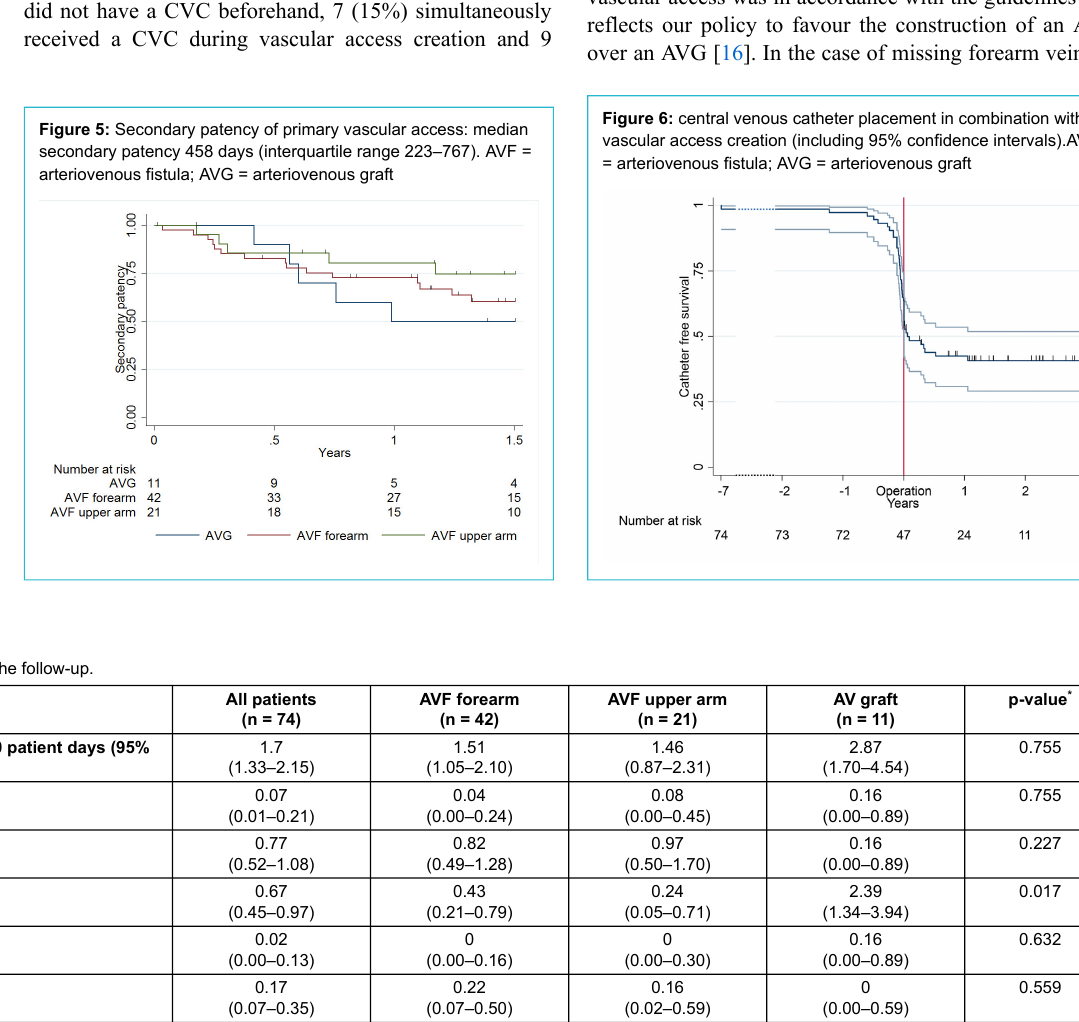
Figure 6: central venous catheter placement in combination with vascular access creation (including 95% confidence intervals).AVF = arteriovenous fistula; AVG = arteriovenous graft